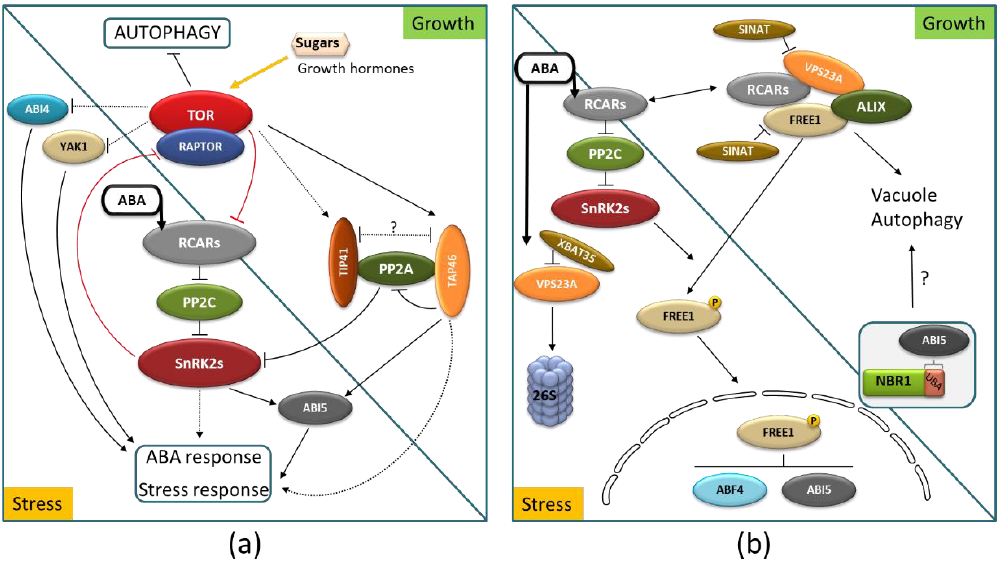
Figure 4. Links of autophagy with ABA signaling in growth and stress responses. ( a ) Reciprocal regulations of TOR and ABA signaling pathways. Red lines mark the main regulation circuit, while the other TOR–ABA connections are marked by the black lines. ( b ) Links of ABA with elements of vesicular transport and an autophagy cargo receptor NBR1. For explanations and references, see the text.